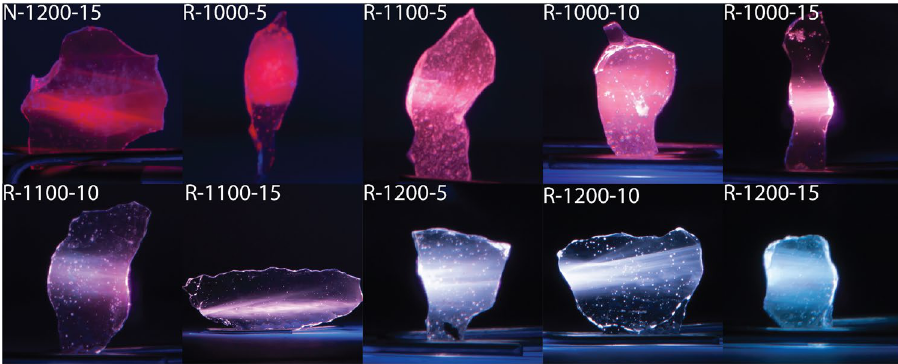
Figure 3. Photographs of the obtained samples illuminated with 405 nm